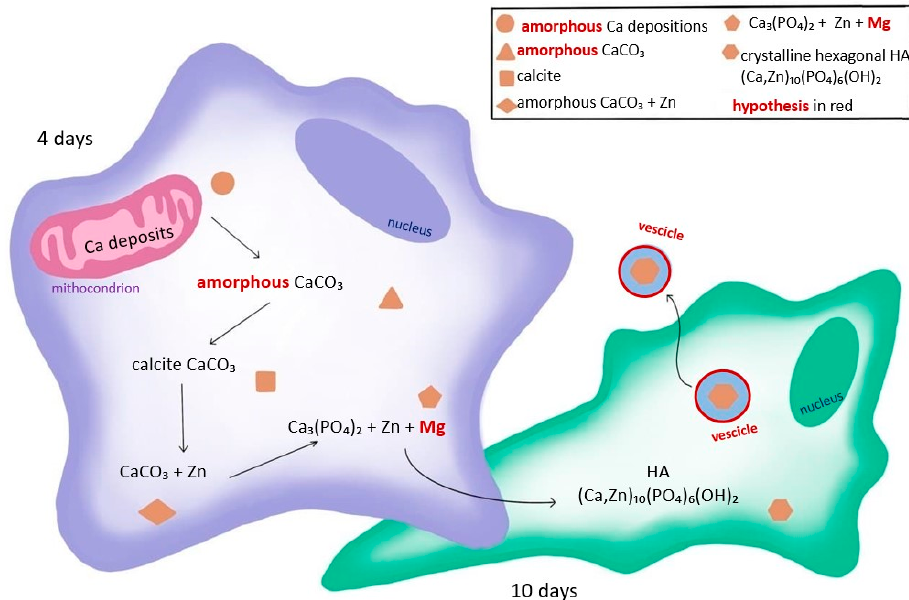
Figure 9. Model of early phases of biomineralization based on the result of this study and results and hypotheses taken from other studies [20,28,29] showing the localization and composition evolution of Ca compounds during the early phases of osteogenic differentiation. For the sake of simplicity, we did not report the transportation of Ca deposition from endoplasmic reticulum to mitochondria, as proposed by Tang et al. [29].